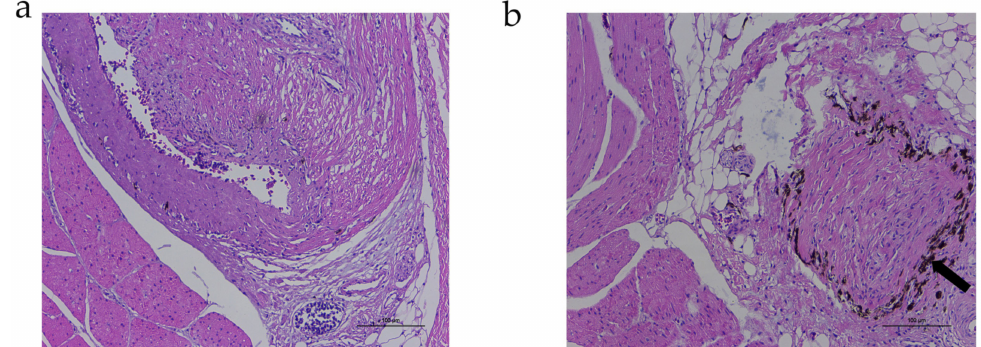
Figure 2. Histomorphological examination of YS and BS from Xichuan black-bone chickens. Dif- ferences in skin melanin deposition and histomorphology between YS ( a ) and BS ( b ). The arrow indicates